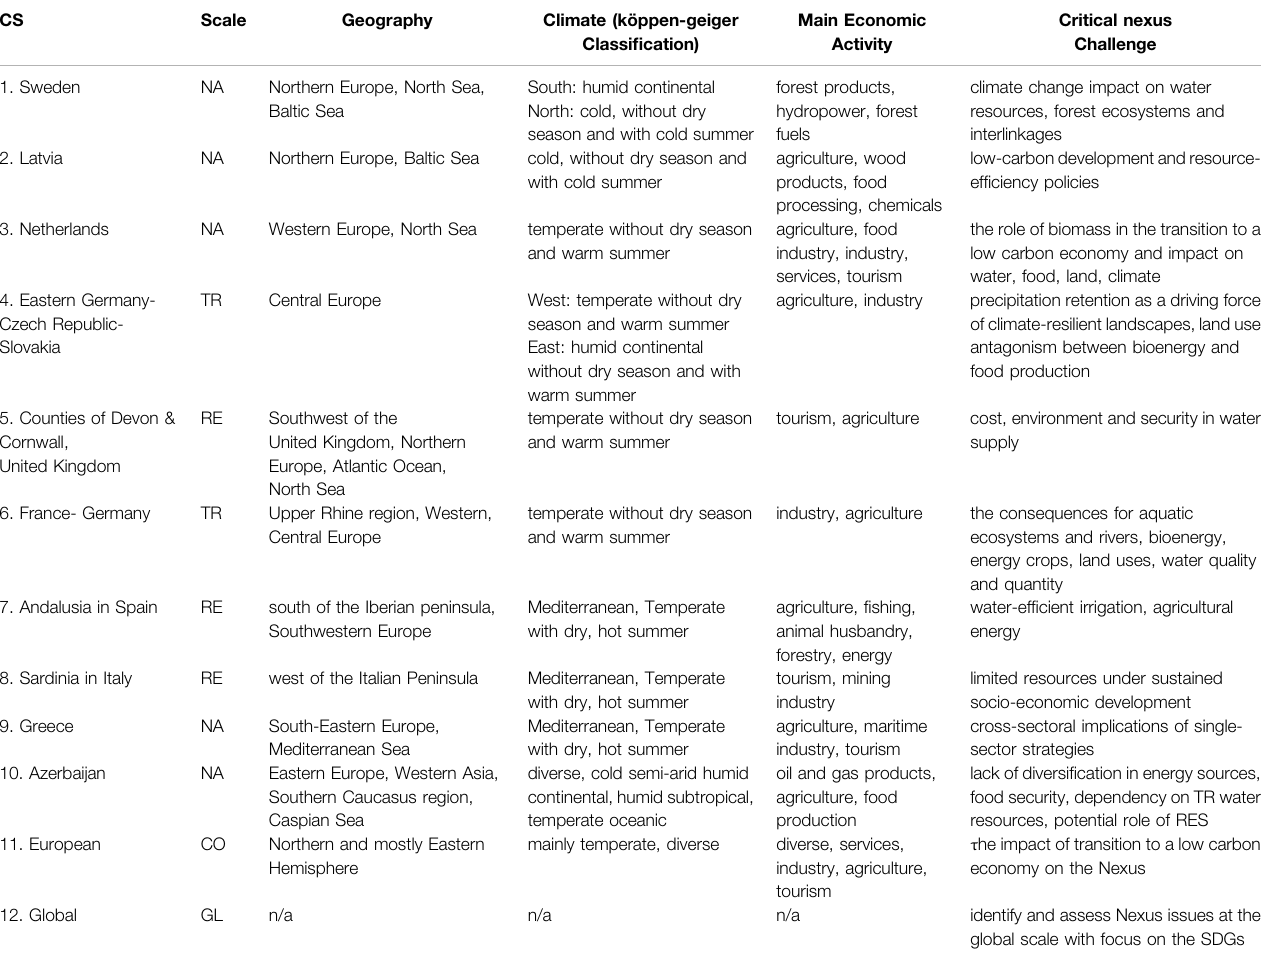
TABLE 1 | The SIM4NEXUS case studies and indicative diversity factors (GL: Global, CO: continental, TR: transboundary, NA: national, RE: regional) (Peel et al., 2007; Brouwer and Fournier, 2017; Fick and Hijmans, 2017; Eurostat and European Commission, 2019).